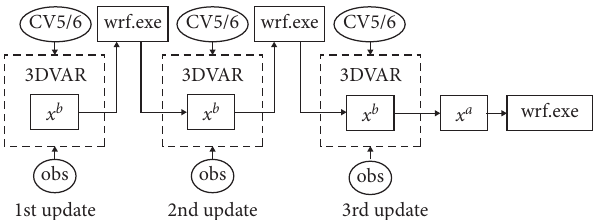
Figure 1: Flowchart of the 3DVAR data assimilation scheme. See details in the